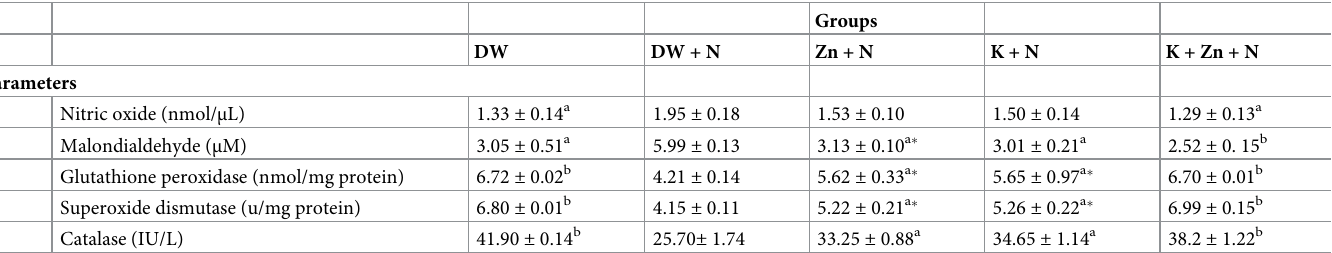
Table 1. Effect of kaempferol and zinc gluconate on concentrations of brain nitric oxide and malondialdehyde, and activities of glutathione peroxidase, catalase and Superoxide dismutase in Wistar rats exposed to noise stress (Mean ± SEM, n = 6). Groups DW DW + N Zn + N K + N K + Zn +